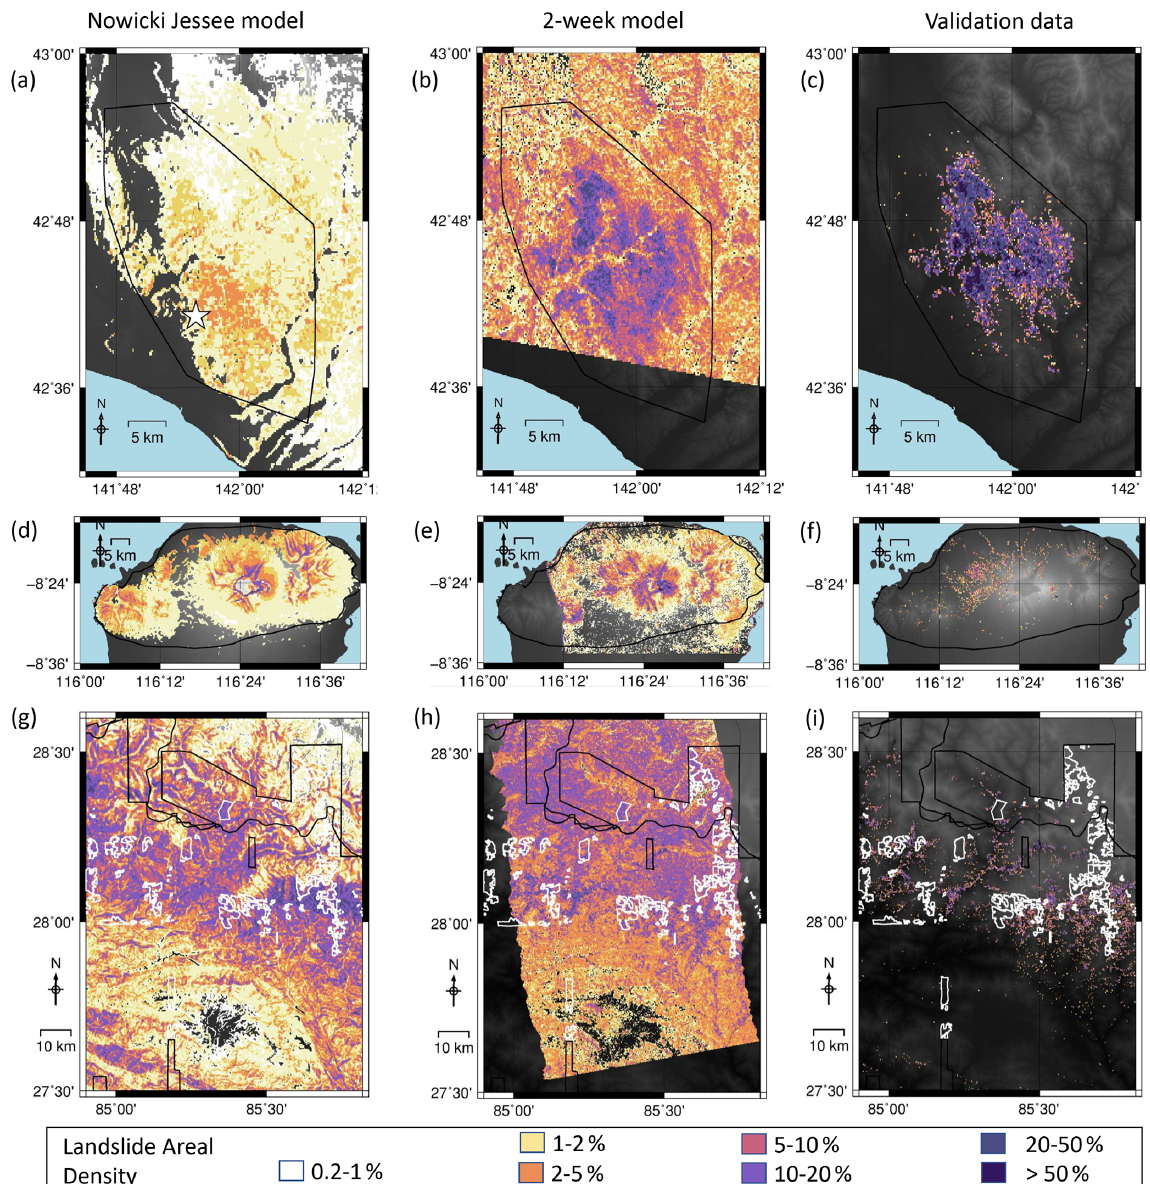
Figure 4. Timelines of modelled landslide areal density for each event. Panels (a) , (d) and (g) show the results of the model of Nowicki Jessee et al. (2018) for each event. Panels (b) , (e) and (h) show the model using SAR data acquired within 2 weeks of the earthquake, and panels (c) , (f) and (i) show landslide areal density calculated from polygon inventories for each event (Ferrario, 2019; Roback et al., 2017; Zhang et al., 2019). The mapping extent of each of these inventories is shown by a black polygon. White polygons in the final row show areas not mapped by Roback et al. (2017) due to cloud cover in optical